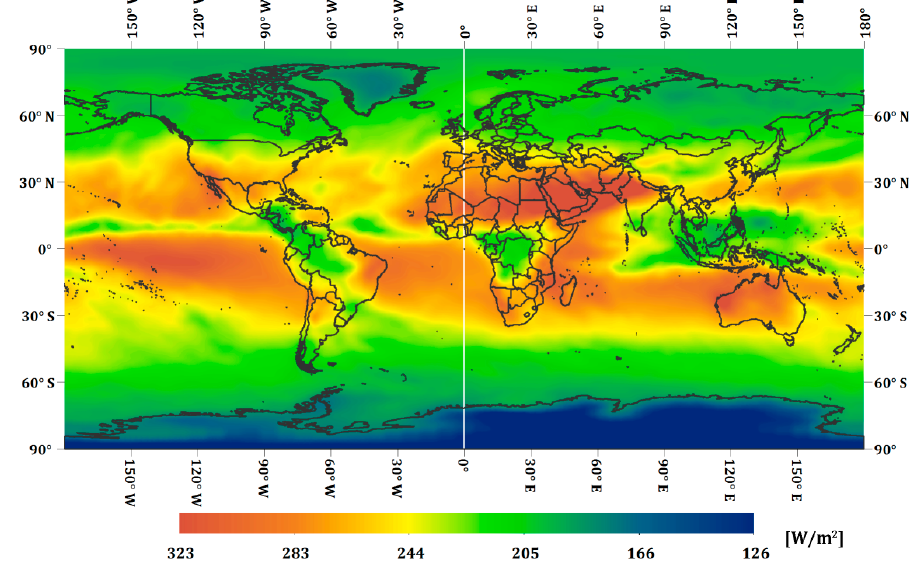
Figure 8. Monthly average Earth TOA LW flux on October 2017 derived from the CERES SYN1deg Ed4A dataset.